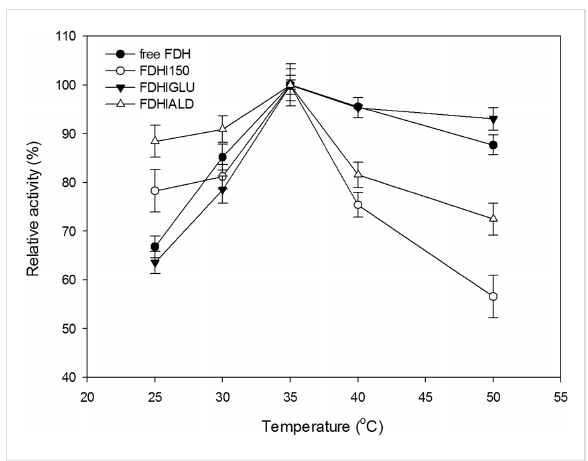
Figure 3: The effect of temperature on the activities of free and immo- bilized FDH preparations. The enzyme activity at 35 °C is taken as 100% for the each preparation. The experiments were run in triplicate.